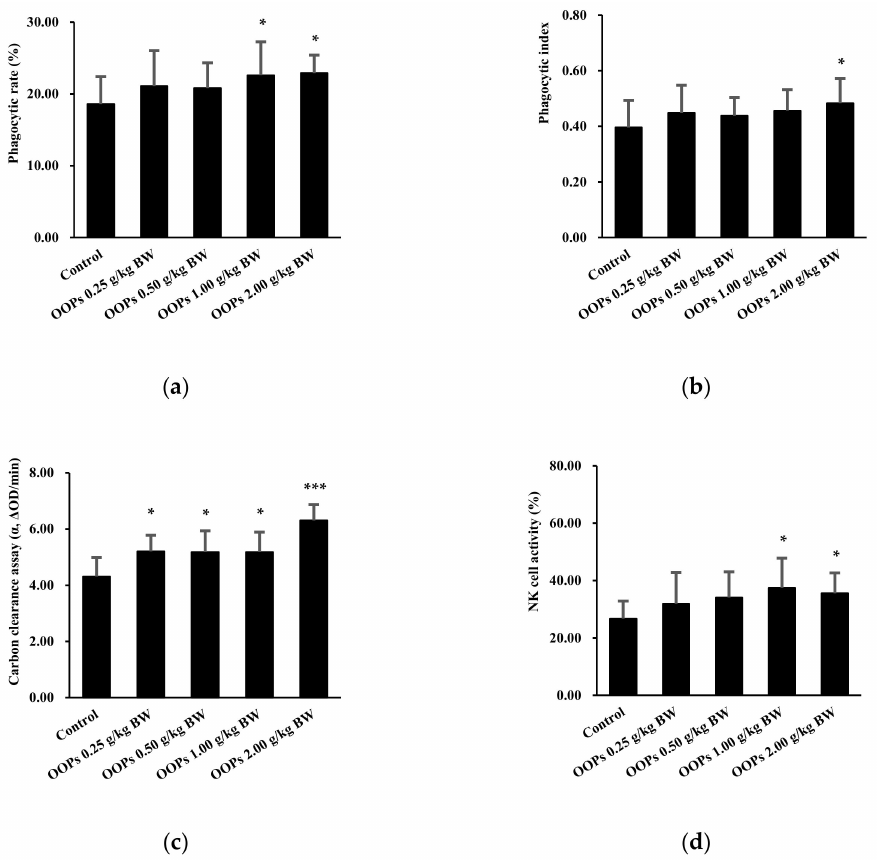
Figure 3. E ff ects of OOPs on macrophage phagocytosis capacity and NK cell activity in mice. ( a ) The phagocytic rate of peritoneal macrophage phagocytosis in CRBCs; ( b ) Phagocytic index of peritoneal macrophage phagocytosis in CRBCs; ( c ) Macrophage phagocytosis in carbon clearance; ( d ) NK cell activity. Data are represented as mean ± SD, n = 10. * p < 0.05 vs. control group, *** p < 0.001 vs. control